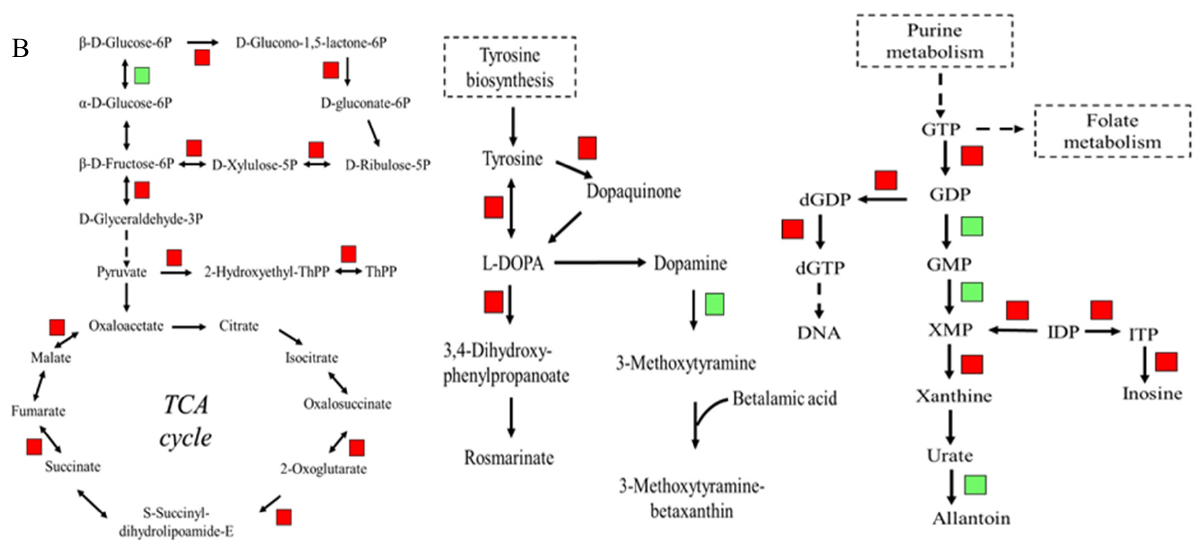
Figure 8. Relative expressions of 26 selected genes ( A ) and metabolic pathways for the dif- ferential metabolites in DSL treatment in comparison to those in D treatment of alfalfa root exudates ( B ). The red boxes represent those upregulated and the green boxes represent those down- regulated in DSL compared to those in D. Results are presented as the mean of four independent experiments ± standard error. * p < 0.05 relative to drought treatment, ** p < 0.01 relative to drought treatment, *** p < 0.001 relative to drought